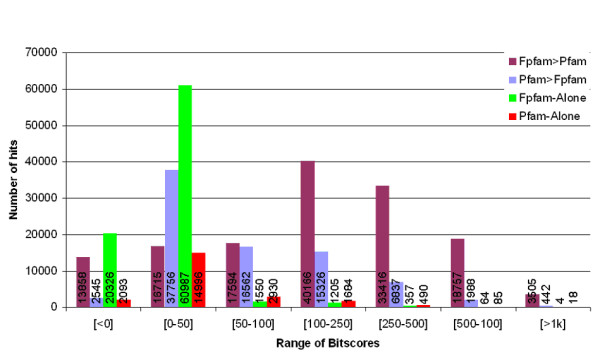
Comparison of bitscore from Fpfam and Pfam HMM libraries in 30 genomes. The X-axis shows different ranges of bitscores for which the frequency of FPfam>Pfam, Pfam>FPfam, no-Pfam and no-FPfam is calculated. To avoid frequencies being counted twice in cases where both Pfam and FPfam results are available, only the maximum score is assigned its respective bin.